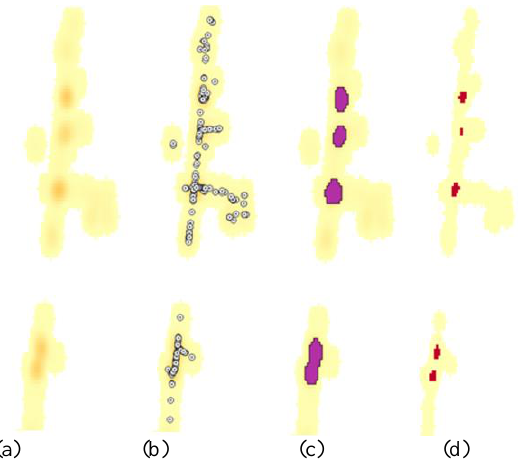
Figure 7. Clustering with kernel estimation. In (c) a low threshold has been used resulting in identifying two near intersections as one (see low part of the figures). In (d) a higher threshold exclude the in between the two high densities noisy samples and make them